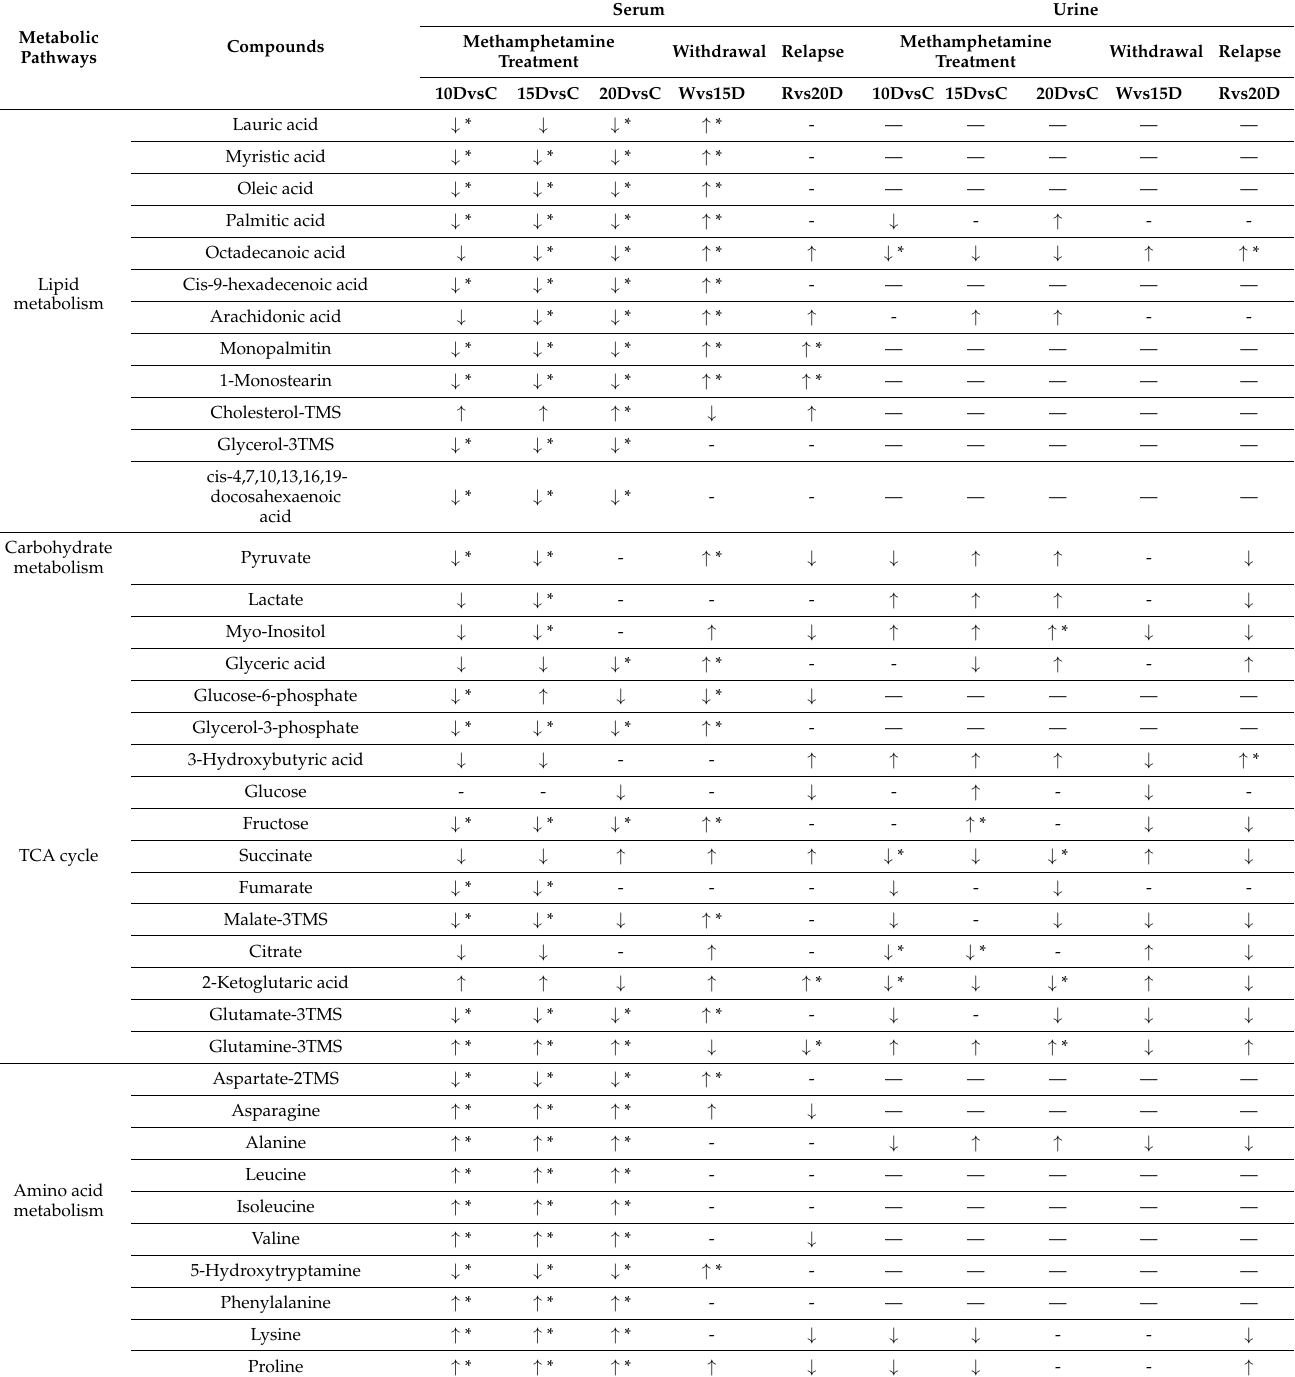
Table 1. Differential metabolites in serum and